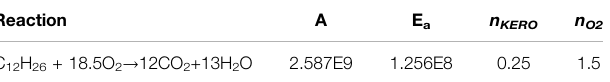
TABLE 1 | Chemical reaction mechanism.